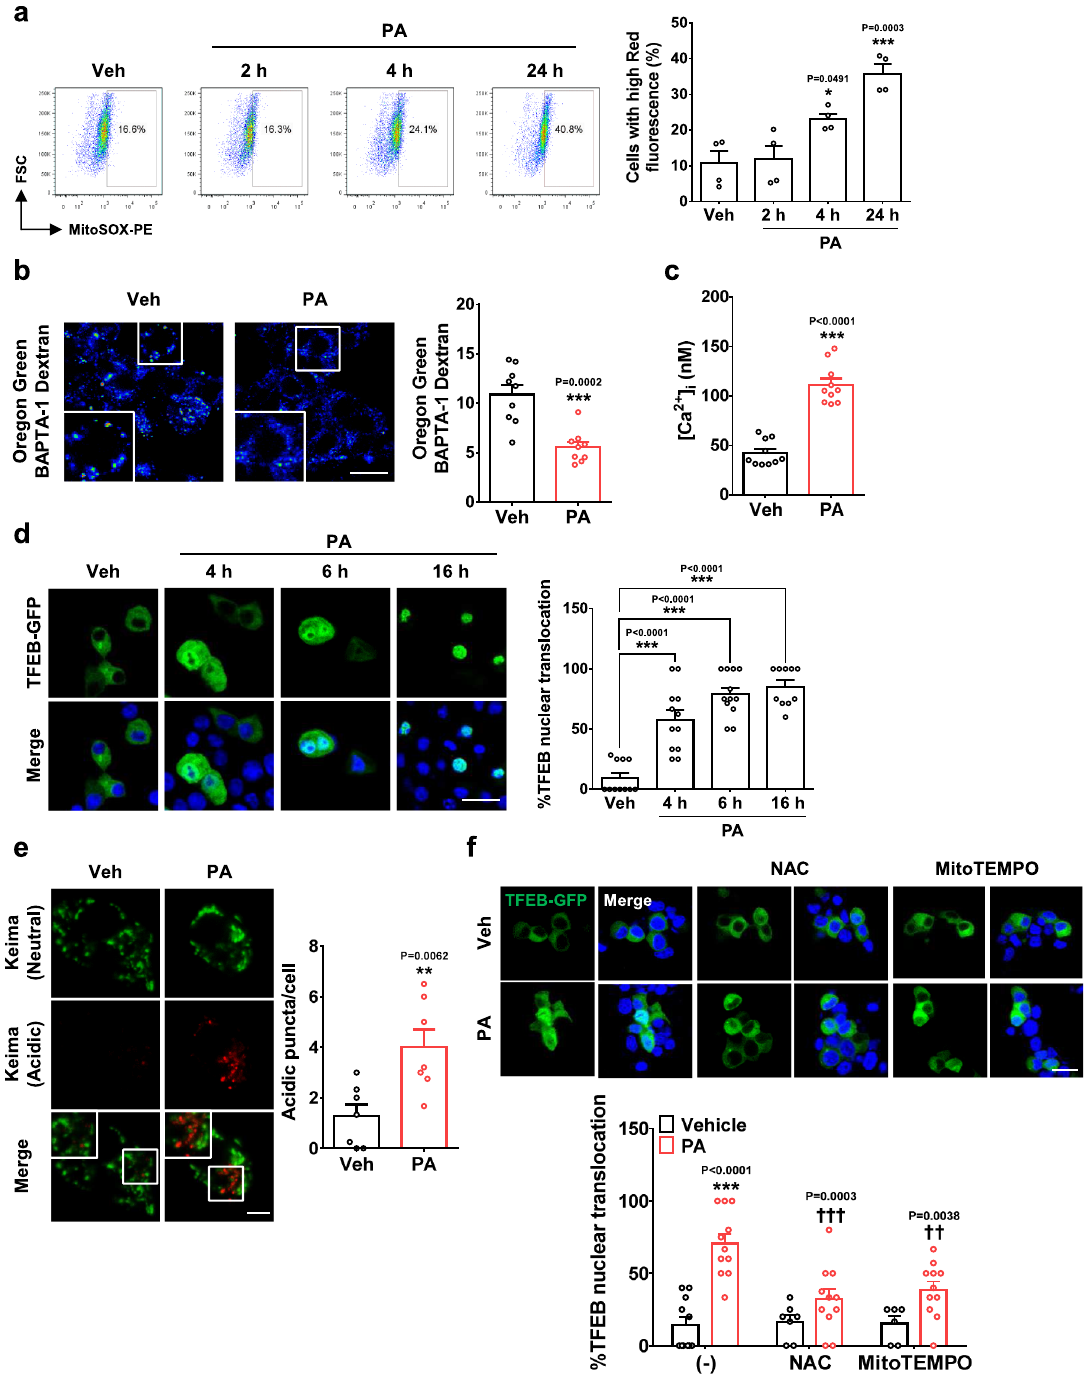
Fig. 4 Effect of PA on mitochondria and mitophagy. a After treating INS-1 cells with PA for 2-24 h, mitochondrial ROS was determined using MitoSOX (right). Representative fl ow cytometric scattergrams are presented (left). ( n = 4) b After treating cells with PA for 1 h, [Ca 2 + ] Lys was determined by Oregon Green 488 BAPTA-1 Dextran loading (right). Representative fl uorescence images are presented (left). (scale bar, 20 μ m) ( n = 9) c After treating cells with PA for 1 h, [Ca 2 + ] i was determined using Fura-2 ( n = 10) d After treating Tfeb-GFP -transfected cells with PA for 4-16 h, nuclear TFEB was examined by confocal microscopy (right). Representative fl uorescence images are presented (left). (scale bar, 20 μ m) ( n = 10 for 16 h; n = 11 for Veh; n = 12 for 4 h or 6 h) e After treating pMito-Keima -transfected cells with PA for 18 h, the number of red acidic puncta in transfected cells was determined (right). Representative fl uorescence images are presented (left). (scale bar, 5 μ m) ( n = 7) f After PA treatment for 4 h with or without ROS quencher pretreatment for 1 h, nuclear TFEB was examined as in ( d ) (lower). Representative fl uorescence images are presented (upper). (scale bar, 20 μ m) ( n = 6 for MitoTEMPO; n = 7 for NAC; n = 11 for Veh, PA, NAC + PA or MitoTEMPO + PA) Cells in the rectangles were magni fi ed. All data in this fi gure are the means ± SEM from more than 3 independent experiments. P values were determined using one-way ANOVA with Tukey ’ s test ( a , d , f ) or two-tailed t test ( b , c , e ). *, compared to Veh-treated cells; † , compared to cells treated with PA alone.